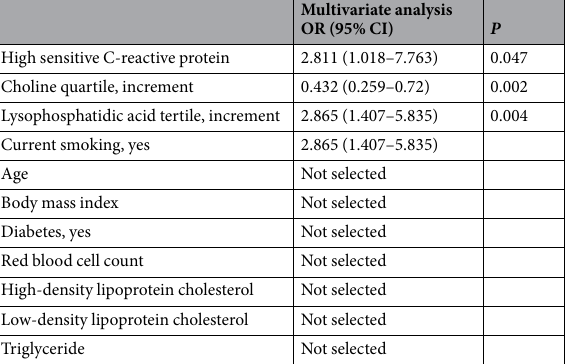
Table 3. Multivariate logistic regression model for the prediction of acute coronary